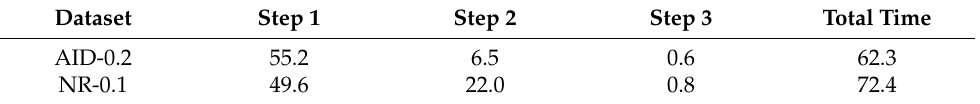
Table 5. Time consumption (s) for constructing the label distributions of all the training samples. Dataset Step